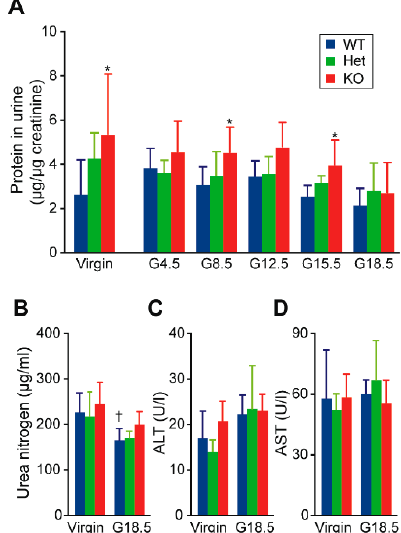
Figure 2. Proteinuria in Cth − / − female mice. ( A ) Urinary protein concentrations of wild-type (WT), Cth +/ − (Het), and Cth − / − (KO) female mice were measured at 8 weeks of age (virgin) and gestating (G) days (G4.5, G8.5, G12.5, G15.5 and G18.5), and normalized by their blood/urine creatinine levels. Urinary samples were collected as temporary urine at 8 weeks of age (virgin) and at G4.5–G18.5. ( B – D ) Serum levels of urea nitrogen ( B ), alanine aminotransferase (ALT) ( C ), and aspartate aminotransferase (AST) ( D ) were measured. Data are represented as mean ± SD ( n = 4–18). The di ff erences versus WT samples were significant at * p < 0.05 and those versus virgin samples were significant at † p <